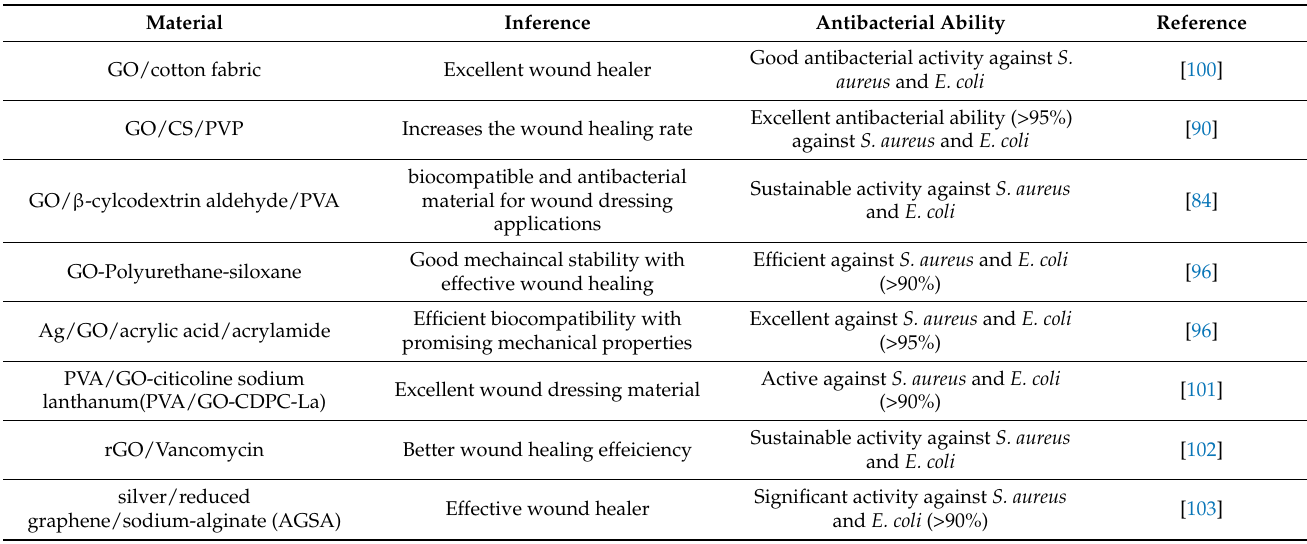
Figure 6. Wound healing ability of polyhexamethylene guanidine hydrochloride (PHMG) grafted graphene oxide (MGO) with thermoplastic polyurethane (TPU) Reprinted with permission from ref. [99] Copyright 2020 Elsevier. Table 3. Examples of graphene-based wound dressing materials.